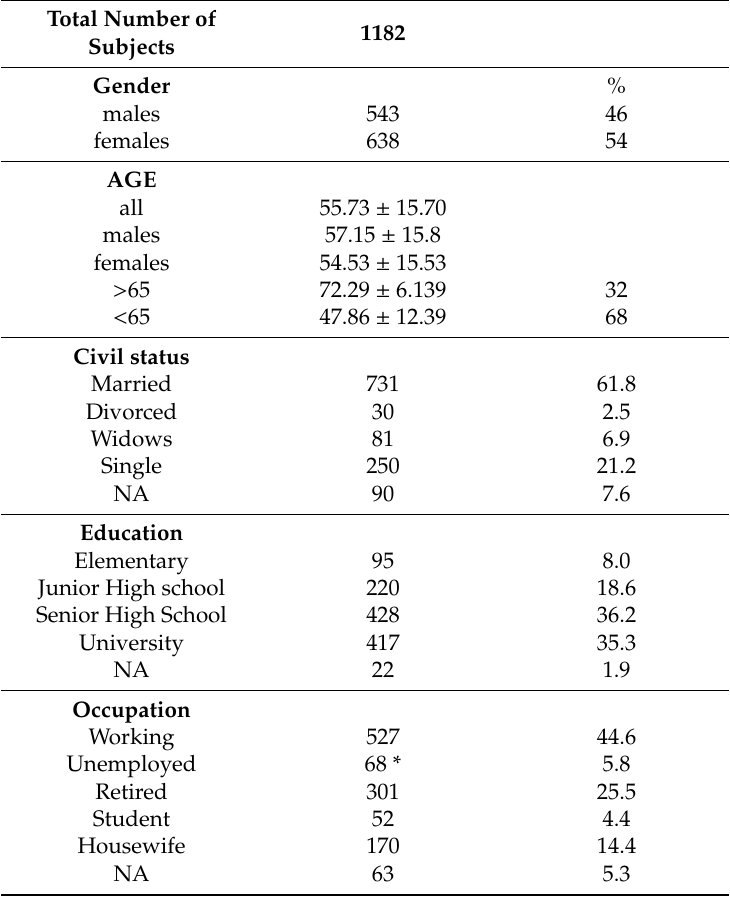
Table 1. Characteristics of the